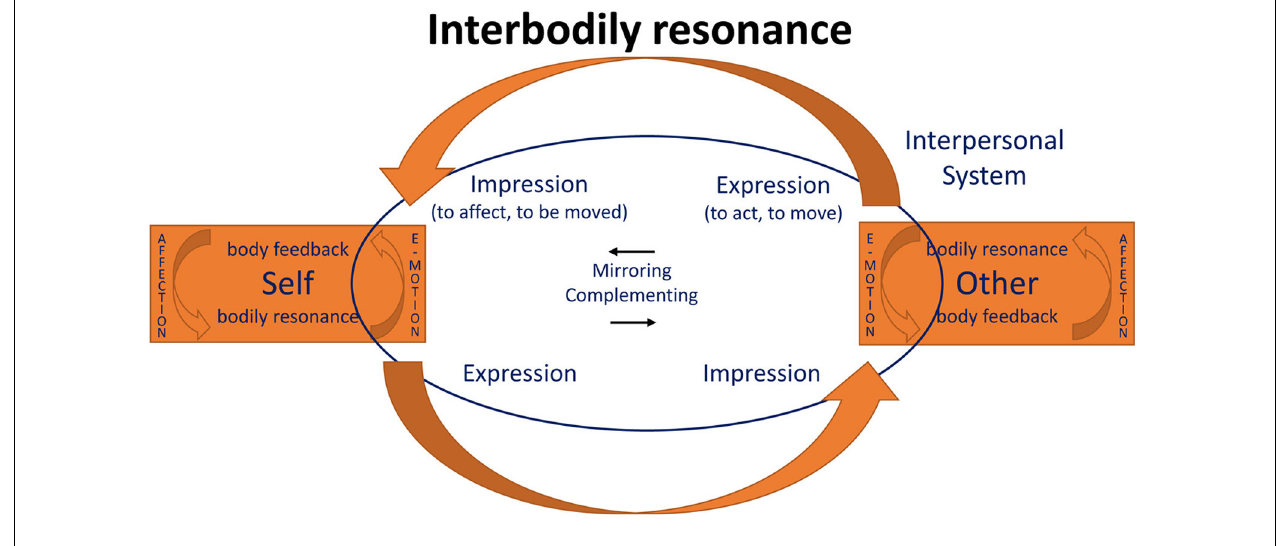
FIGURE 2 | Interaffectivity. The figure is an integration of Koch (2011), Froese and Fuchs (2012), and Fuchs (2013). Interaffectivity includes body feedback (i.e., the impression function within self and other) which is necessary for interbodily resonance. Components of interbodily resonance